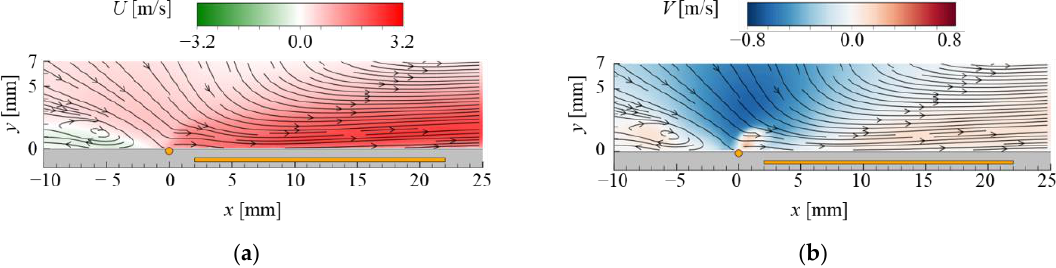
Figure 13. Photograph of the discharge emission of the wire-PA. An enlarged view of the area around the discharge is shown in the red frame: ( a ) row image; ( b ) binarized image.